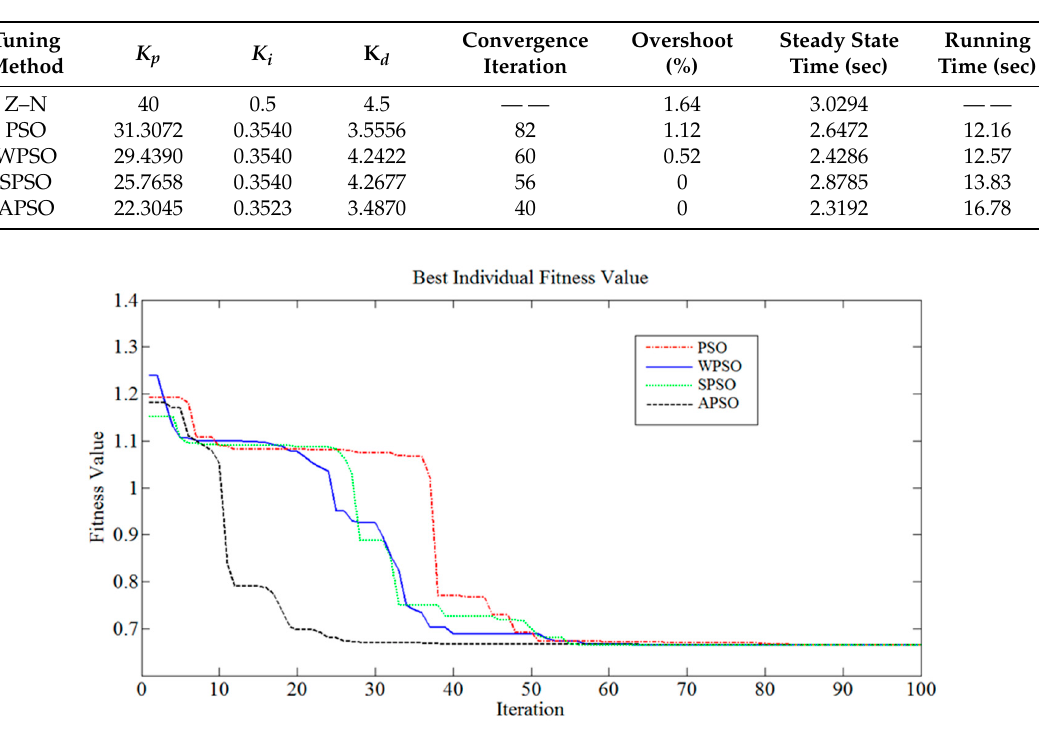
Figure 7. Comparison between the response curves derived from the step input . 6. Conclusions In order to imitate the actual pressure of the hydraulic support, a hybrid algorithm with PSO and GA was proposed to optimize the PID controller. The data of the control voltage of the proportional relief valve amplifier and pillar pressure were collected to acquire the system transfer function using the system identification toolbox of MATLAB. The selection and crossover operations were introduced into the PSO algorithm to avoid the local optimization and to improve the convergence velocity. Several simulations with different methods were performed to compare the optimization capacity. Finally, the experiment on the HSEHCE test platform was conducted to validate the efficiency of the proposed method. The simulation and experiment results showed that